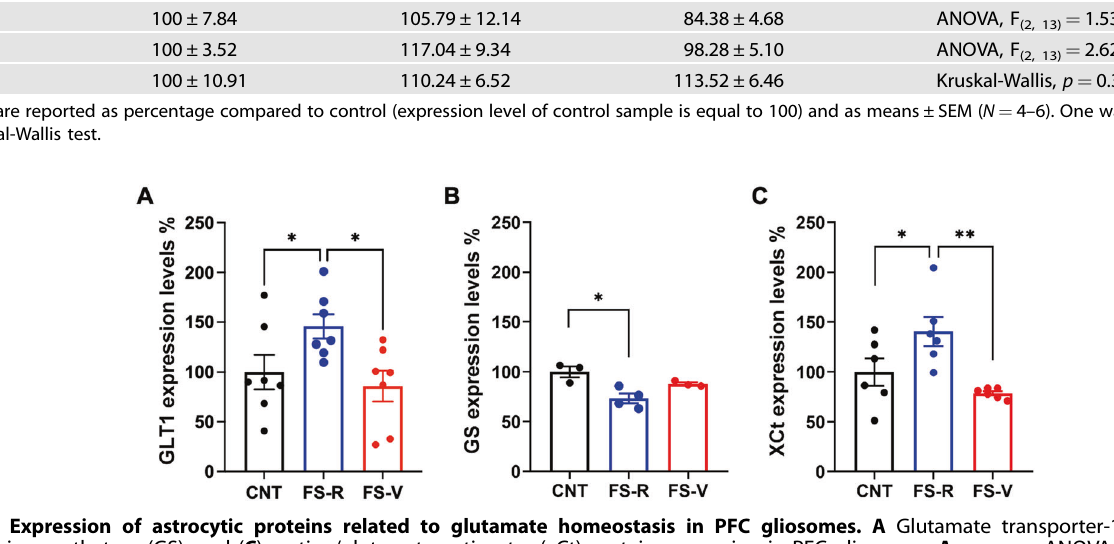
Table 4. Summary of functional, molecular, and structural differences between FS-R and FS-V animals in PFC synaptosomes, gliosomes, and whole tissue. PFC SYNAPTOSOMES FS-R FS-V = ↑ ↑ ↑ ↑ ↑ ↓ ↓ GluN2A protein levels and GluN2A/GluN2B ratio (synaptic membranes) PFC GLIOSOMES Basal glutamate release = = Depolarization-evoked glutamate release = ↑ GLT1 protein levels ↑ = GS protein levels ↓ = XCt protein levels ↑ = TOTAL PFC ↓ ↓ Dendritic length and branching (prelimbic PFC layers II – III pyramidal neurons) BDNF mRNA levels = ↓ GDNF mRNA levels = = Arrows/equals represent the comparison vs control animals. The parameters which were found different between FS-R and FS-V rats are highlighted in